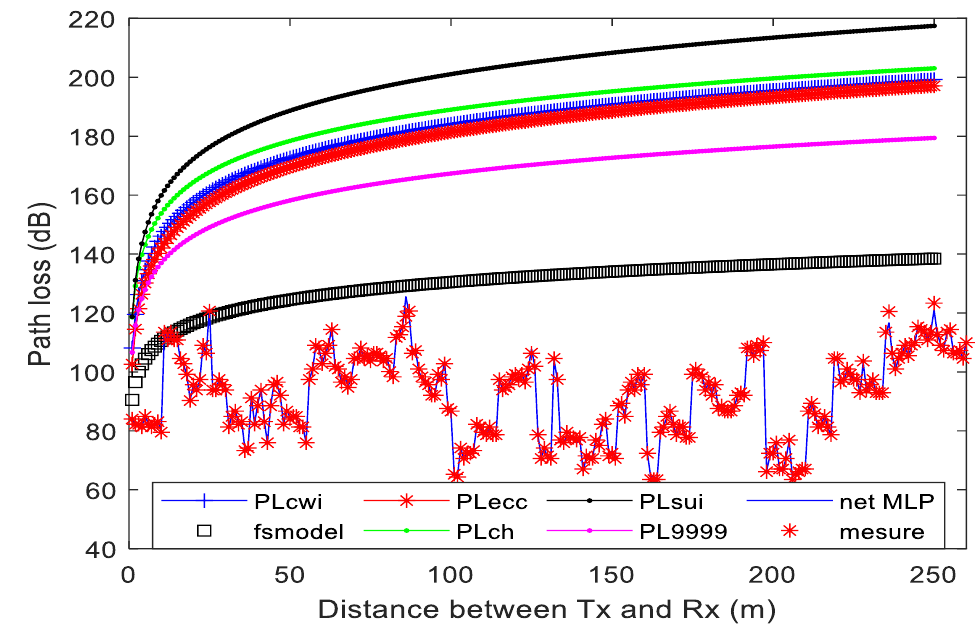
Figure 15. Comparison between empirical models and MLP (with two hidden layers) for Dataset 5.